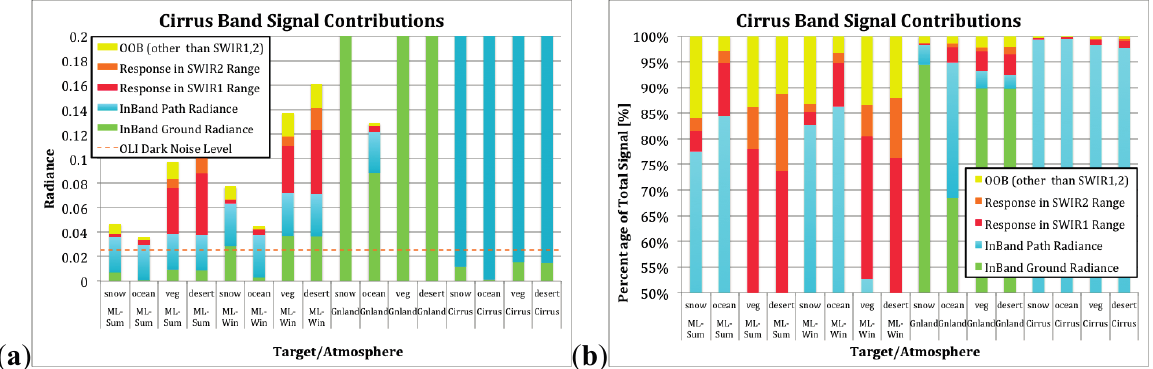
Figure 16. ( a ) Simulated Cirrus band radiances for various targets and atmospheres. The scale is expanded in order to see the small signal levels; ( b ) Cirrus signal plotted as a percentage of the total satellite-reaching